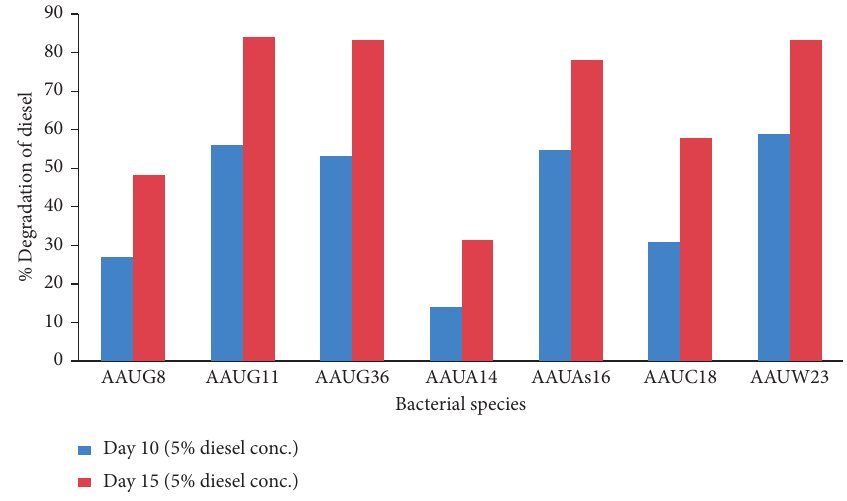
Figure 3: Gravimetric analysis for diesel degradation.